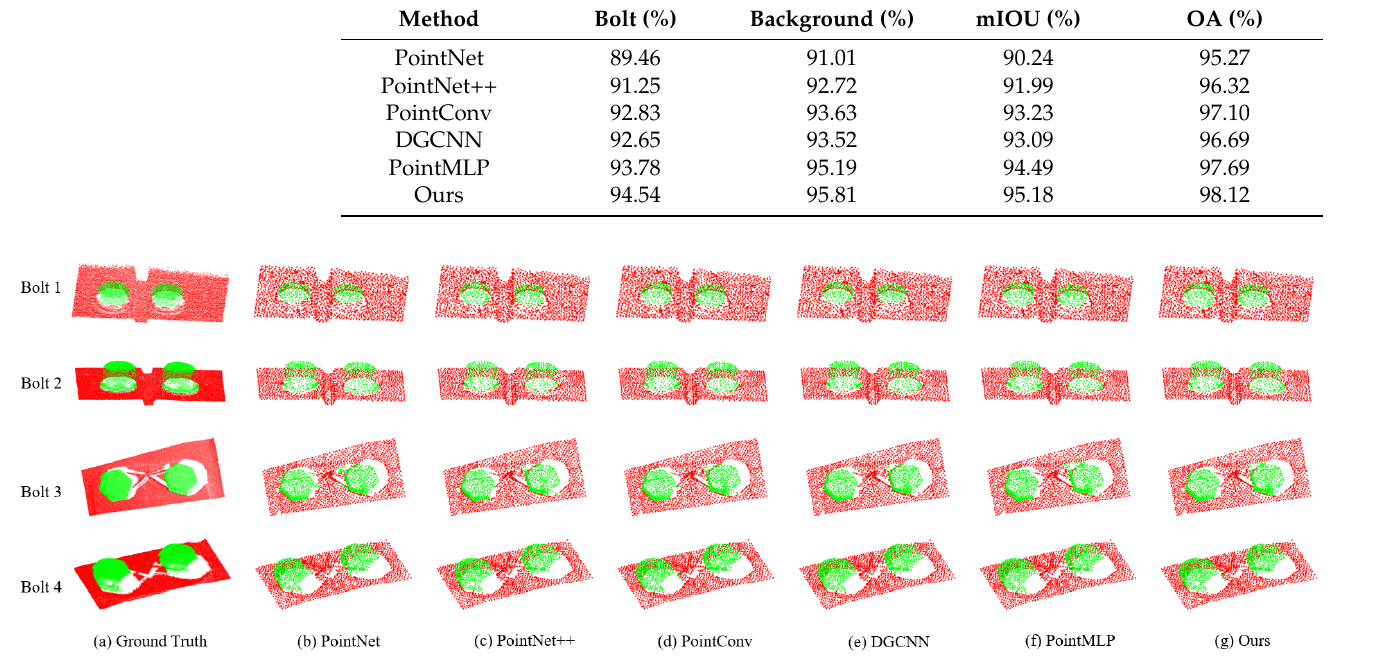
Figure 8. Comparison results of the segmentation.